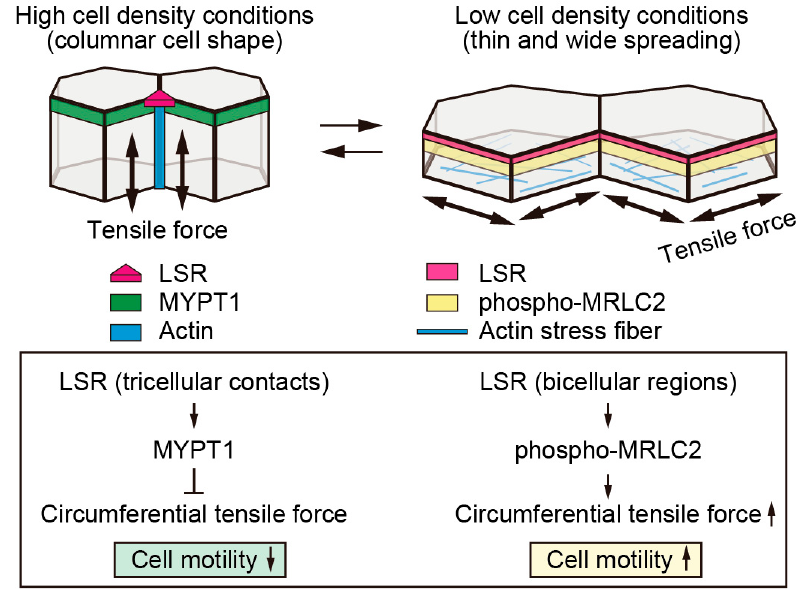
Figure 4. Decreased cellular tension causes LSR to localize at tricellular contacts. At high cell density, where cells were grown with columnar shape, the cellular tension decreased in the circumferential direction because MYPT1 is localized in these regions. Under these conditions, LSR is localized in tricellular contacts. In contrast, higher tension existed in cell-cell junctions at lower cell density because the phosphorylated form of MRLC2 is localized in these regions. In addition, actin stress fibers formed adjacent to the basal membrane. Under these conditions, LSR localized in bicellular junctions. It is noteworthy that thin and wide spreading cells increase cell motility.